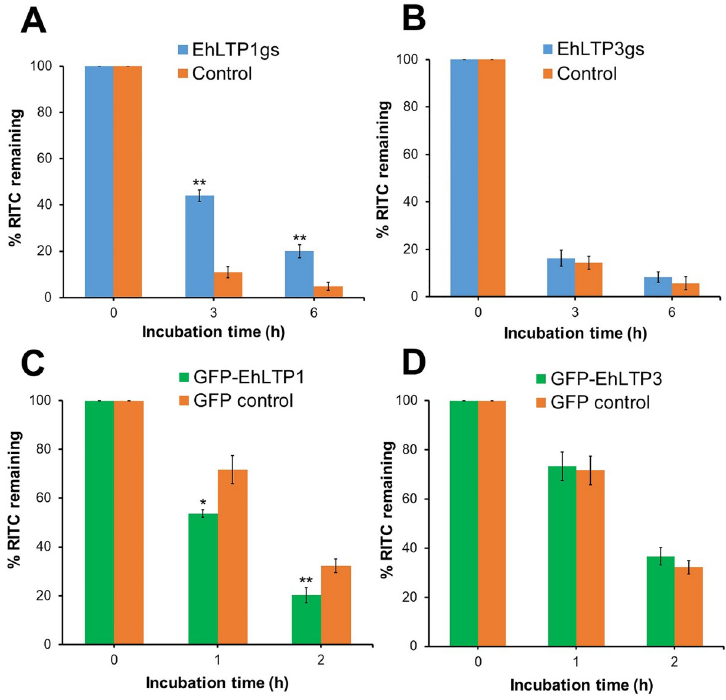
Fig 4. Effects of gene silencing of EhLTP1 (A) and EhLTP3 (B) or overexpression of EhLTP1 (C) and EhLTP3 (D) on exocytosis of the fluid-phase marker RITC dextran. E . histolytica gene silenced transformants [EhLTP1gs or EhLTP3gs, (A) or (B), respectively], overexpressing transformants [GFP-EhLTP1 or GFP-EhLTP3 (C) or (D), respectively] and their corresponding vector control [psAP2 control (A, B) or GFP control (C, D)] cell lines were incubated with 2 mg ml -1 of the fluid-phase marker RITC dextran for 3 h, and then chased for indicated time. Cells were collected, washed, and the fluorescence of incorporated RITC-dextran was measured using a fluorometer as per the method described in Methods. The experiment was repeated three times independently in duplicates (N = 3 with error bars indicating standard deviation). Statistical comparisons were made by Student’s t-test ( � P � 0.05, �� P � 0.005, ��� P �